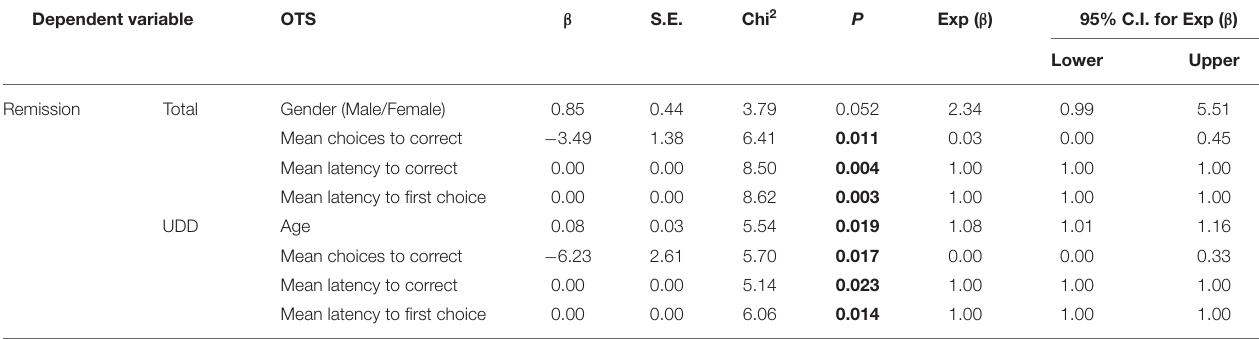
TABLE 7 | Binary logistic regression analysis: demographic and OTS predictors of remission. Dependent